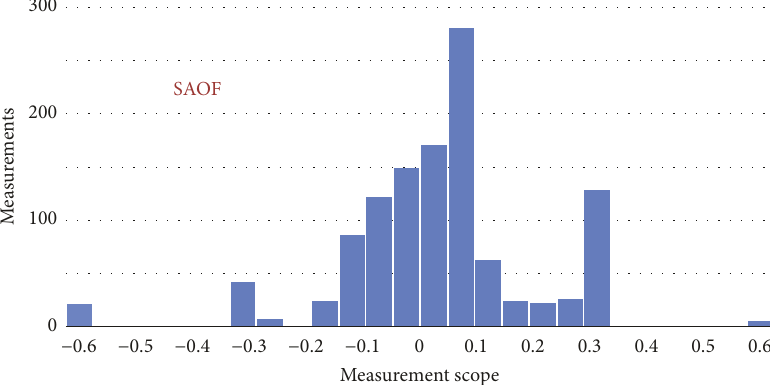
Figure 7: Measurement score distribution for the SAOF algorithm.